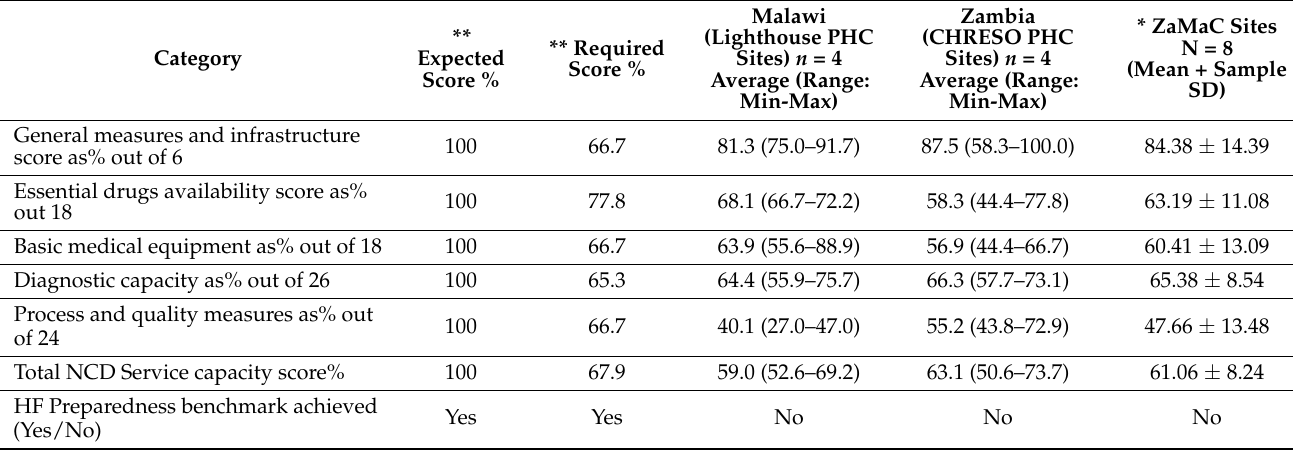
Table 2. Summary comparison of facility capacity by country network versus service